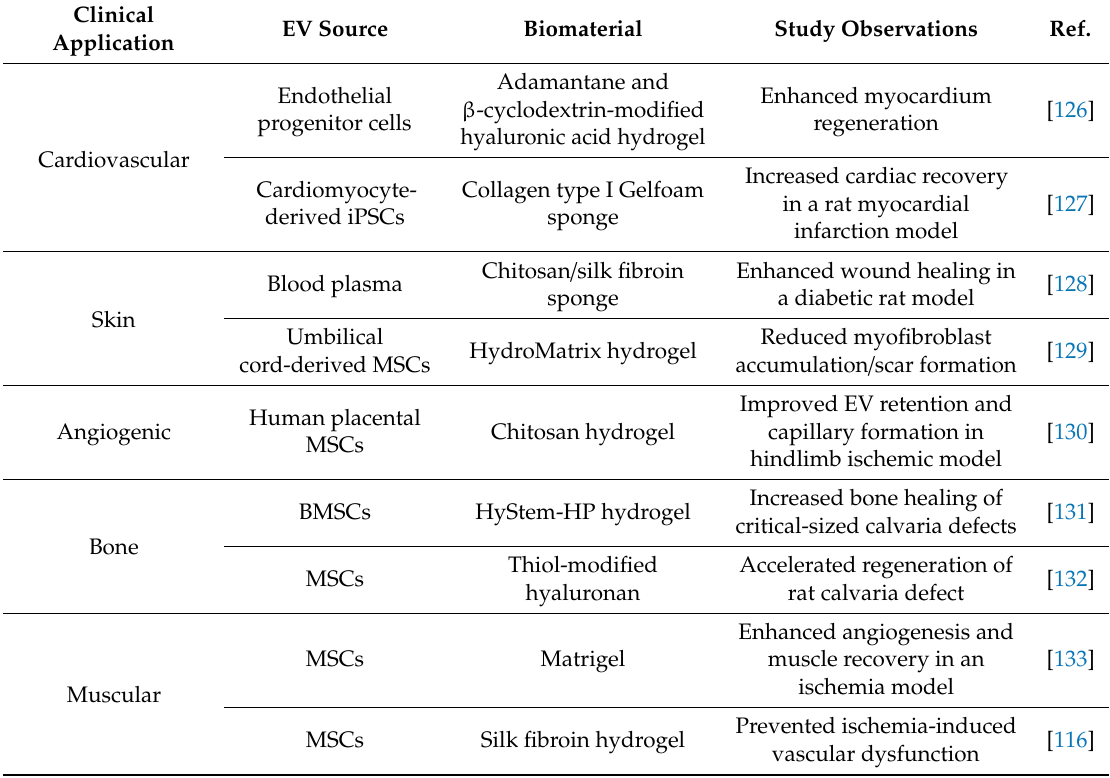
Table 4. Delivery of EVs within biomaterial sca ff olds for tissue regeneration in various